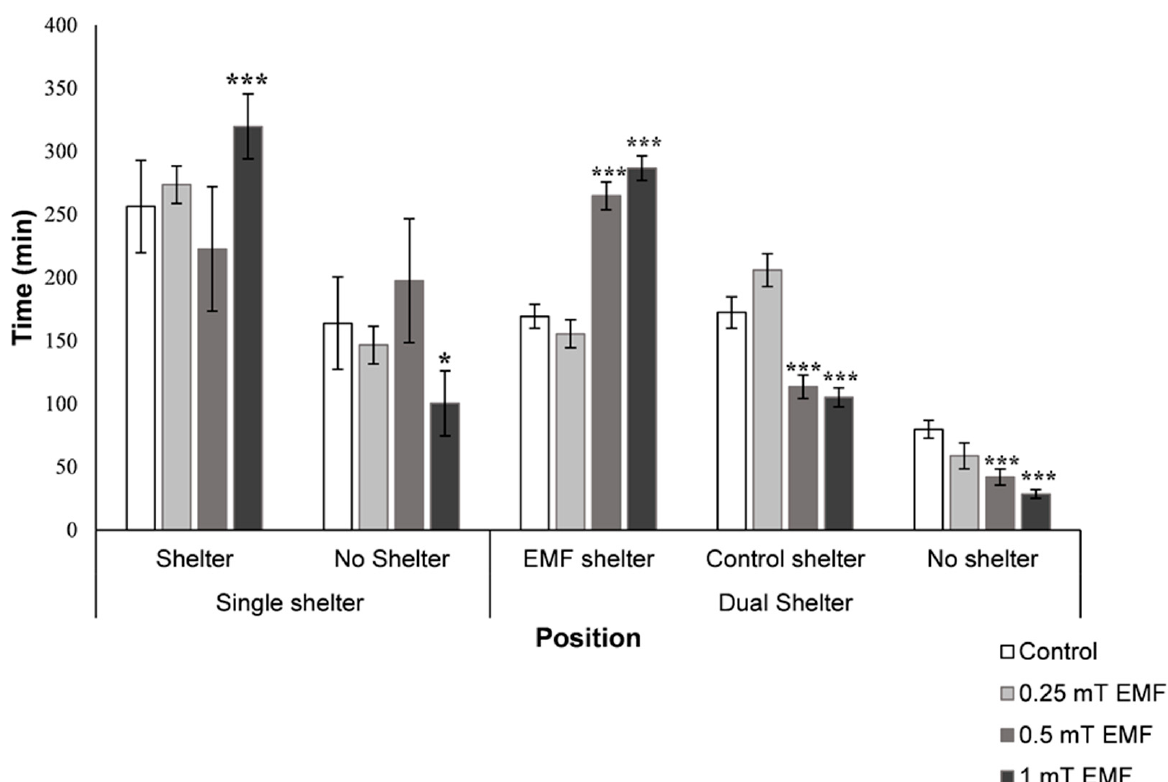
Figure 5. The effects of EMF exposure at various strengths on shelter selection in C. pagurus . Mean time spent in the shelter and roaming the tank (no shelter) in control conditions and exposure to 250 µ T, 500 µ T, and 1000 µ T EMF in single shelter trials. Mean time spent within control and EMF exposed (250 µ T, 500 µ T, and 1000 µ T EMF) shelter and roaming the tank (no shelter) in dual shelter trials. Calculated as time spent in each location compared to total trial length. Values are presented as mean ± SEM, * is the significance at p < 0.05, *** is the significance at p < 0.001. Single shelter N CONTROL = 10, N EMF = 10, dual shelter N CONTROL = 10, N EMF = 10.